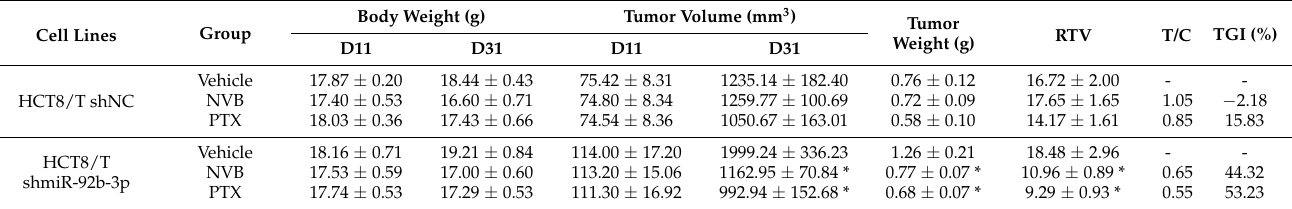
Table 5. Knockdown of miR-92b-3p increases the sensitivity of HCT8/T xenograft tumors to chemotherapeutic drugs. The change of body weight, tumor volume, tumor weight, and RTV over time after HCT8/T shNC and shmiR-92b-3p cells inoculation. versus vehicle group, respectively. * p <